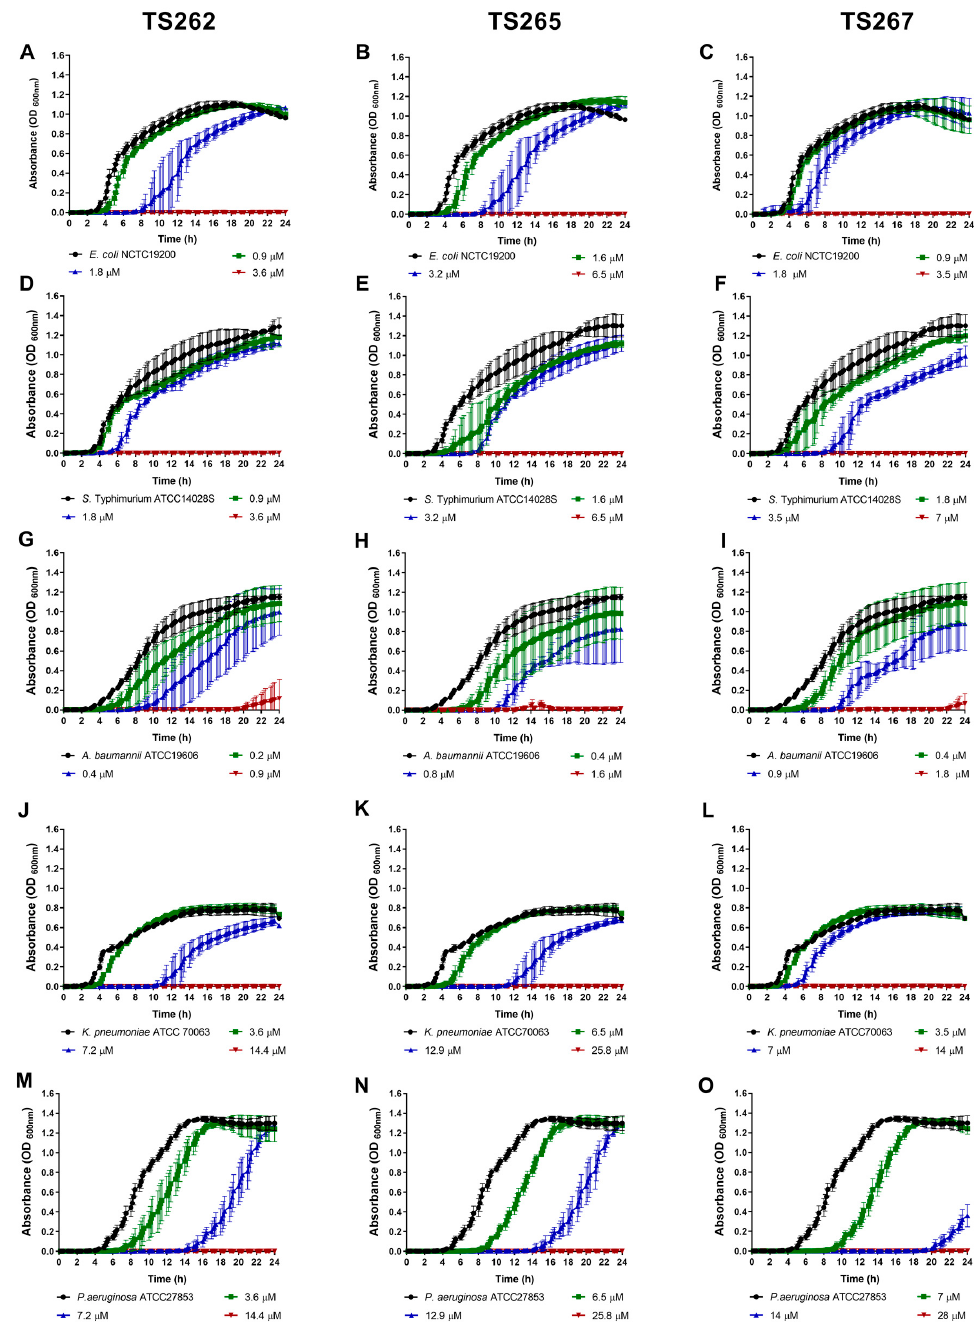
Figure 2. Growth kinetics of Gram-negative bacteria in the presence of the three metallic